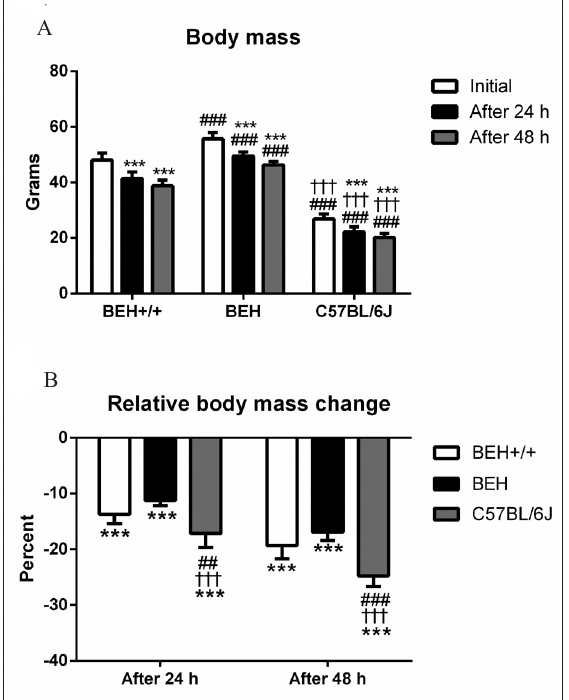
Figure 1. (A) Body mass as well as (B) percentage change in body mass of BEH+/+, BEH and C57BL/6J mice after 24 and 48 h of